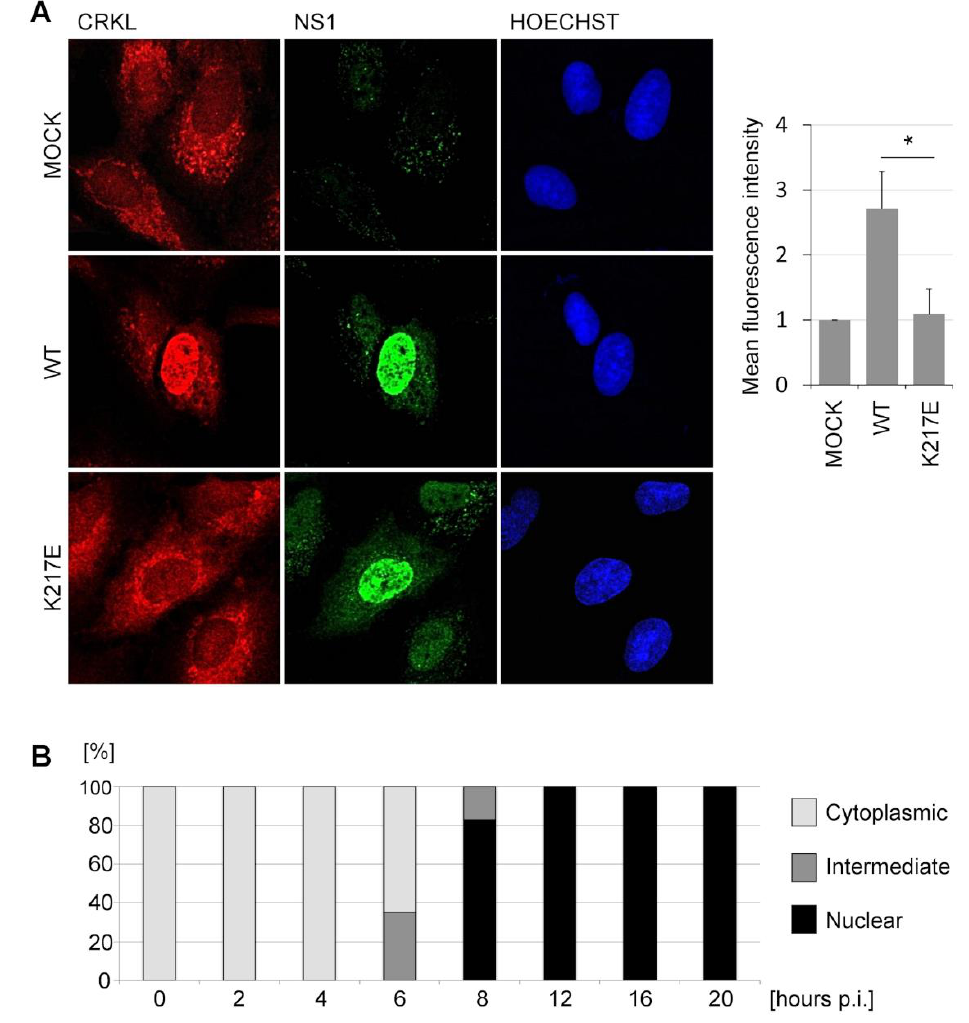
Figure 2. Infection of cells with IAV expressing SH3 binding-competent NS1 causes nuclear relocalization of CrkL. ( A ) Immunofluorescence staining of NS1 and CrkL in A549 cells that were mock-infected (upper panel) or infected with A/WSN-NS1 Mallard(wt) (middle panel) or A/WSN-NS1 Mallard(K217E) (bottom panel) for 20 h at a MOI 0.5. The nuclei were visualized by staining with Hoechst. The mean intensity of CrkL fluorescence in the nuclei was quantified from 50 cells infected with A/WSN-NS1 Mallard(wt) or A/WSN-NS1 Mallard(K217E) that also stained positive for NS1, and was normalized to the mean fluorescence intensity of CrkL immunostaining of 50 mock-infected cells. The standard error is presented in the figure. The statistical significance of the differences was determined by Student ′ s t-test (* p < 0.001); ( B ) A549 cells were infected with A/WSN-NS1 Mallard(wt) for different time points at a MOI 0.5. The localization of CrkL was scored from 100 cells as a cytoplasmic, an intermediate, or a nuclear pattern.